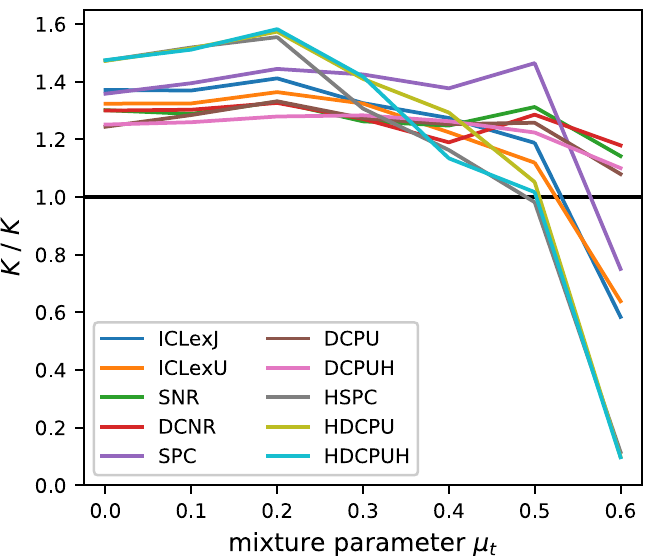
Fig 16. Ratio of average selected number of blocks � K to average true number of blocks K of those SBM variants including model selection. The values shown are based on the same setting as Fig 17.